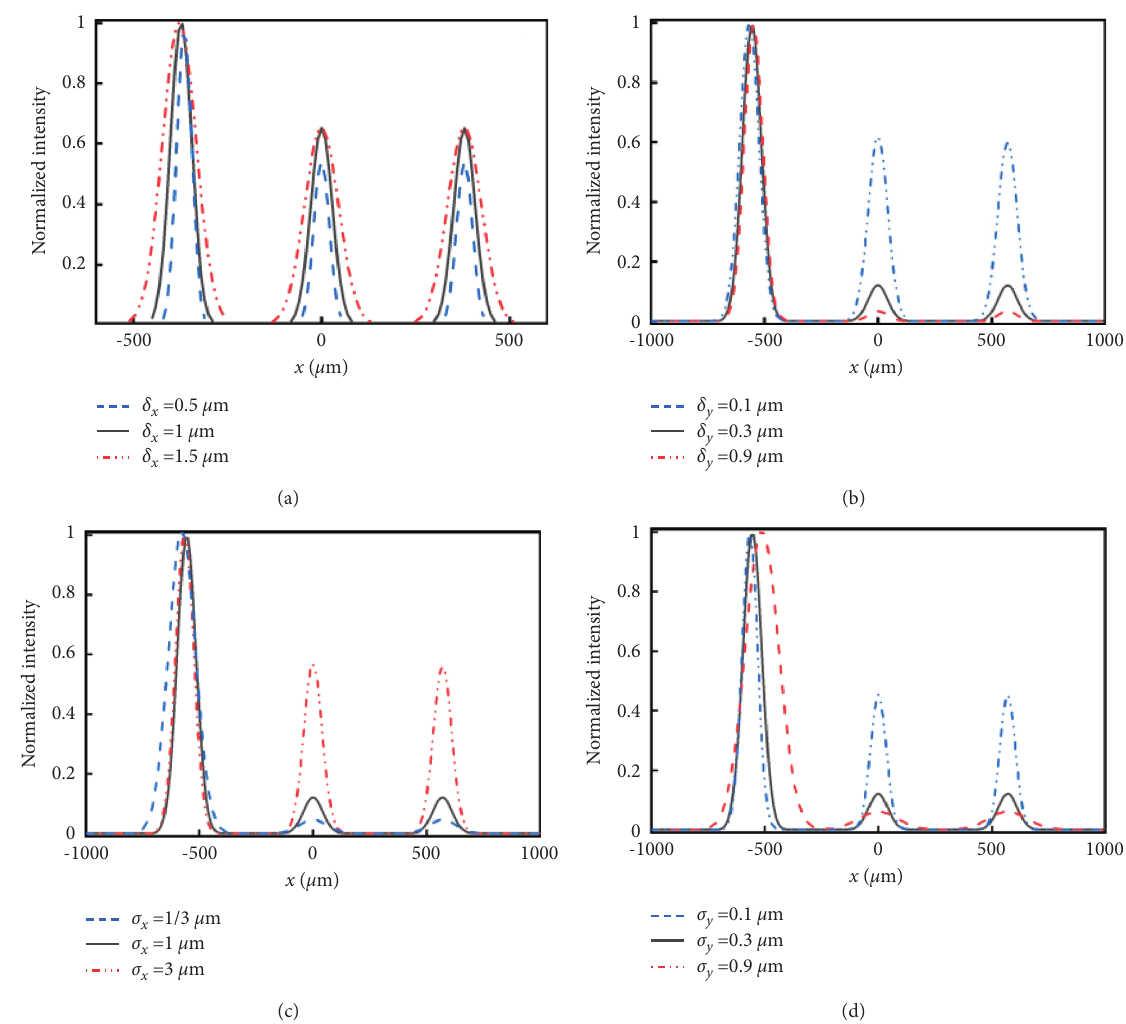
Figure 3: Intensity distribution of TGSMA beams at propagation distance z � 200um for different source parameters, and biological tissue medium parameters are chosen, D f � 2.60, l c � 10.24 μ m; (a) σ x � 1 μ m, σ y � 0.3 μ m, R x / δ x � 3; (b) σ x � 1 μ m, σ y � 0.3 μ m, R y / δ y �